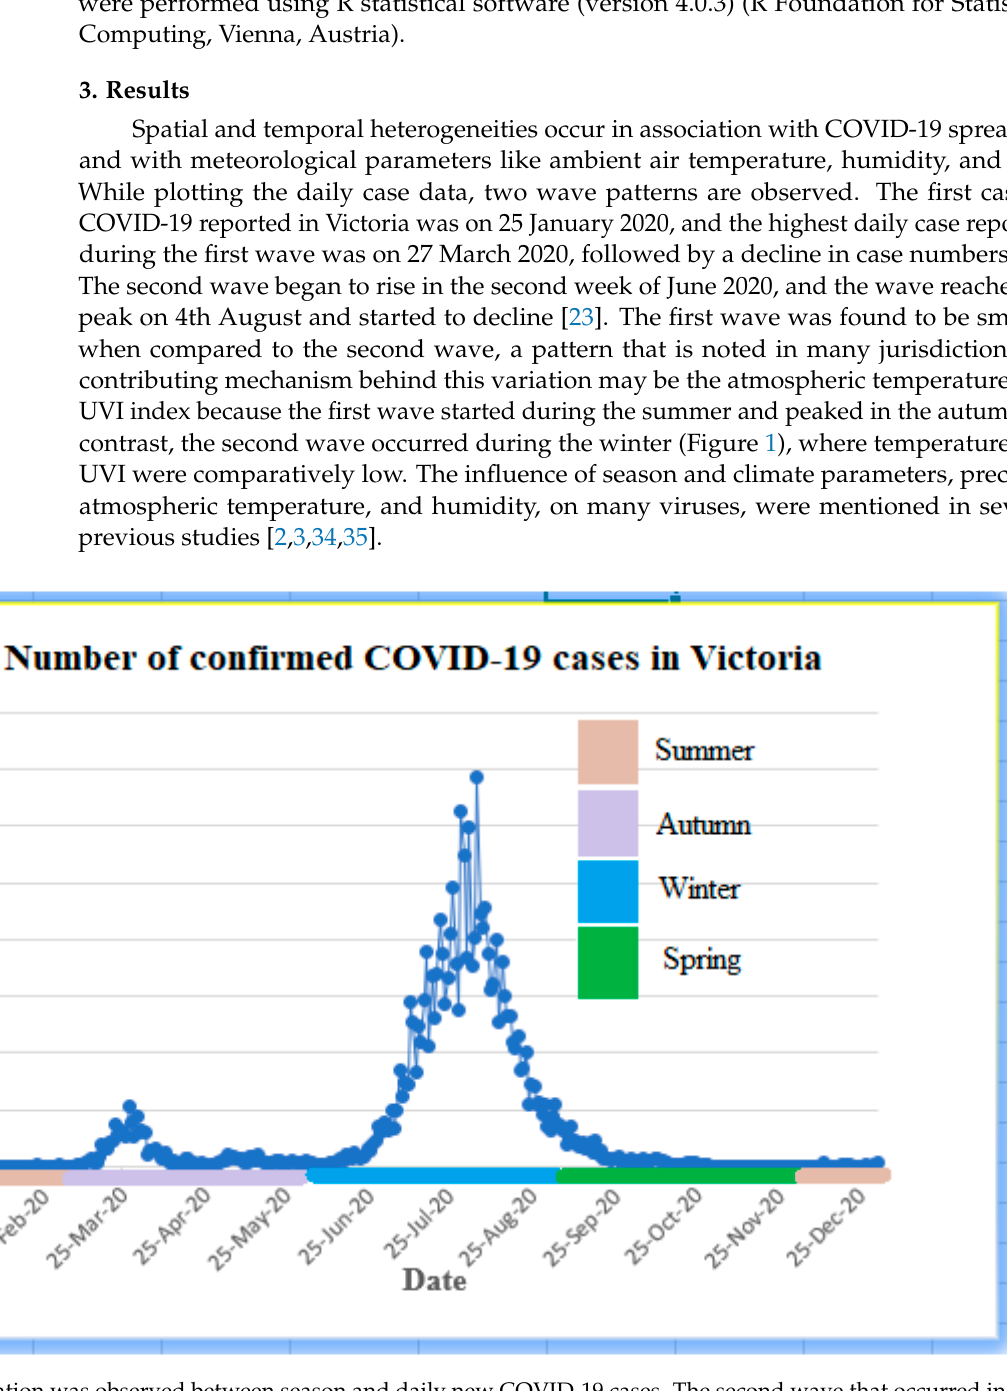
Figure 1. An association was observed between season and daily new COVID-19 cases. The second wave that occurred in winter has a high peak compared to the first wave.